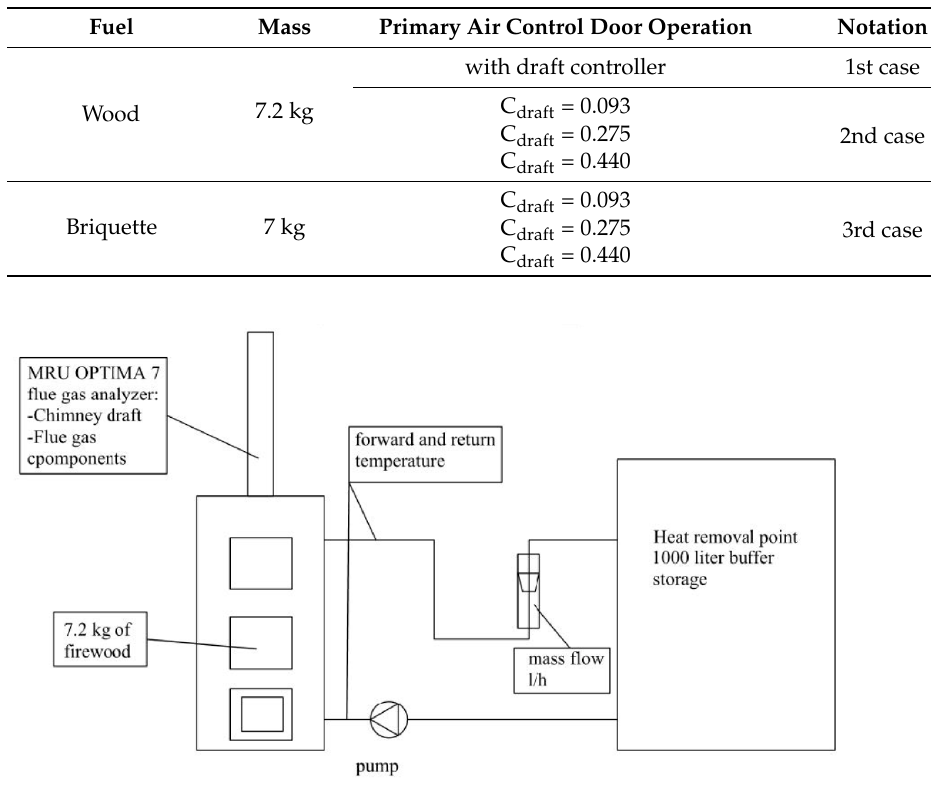
Figure 3. Schematic arrangement of measuring station.